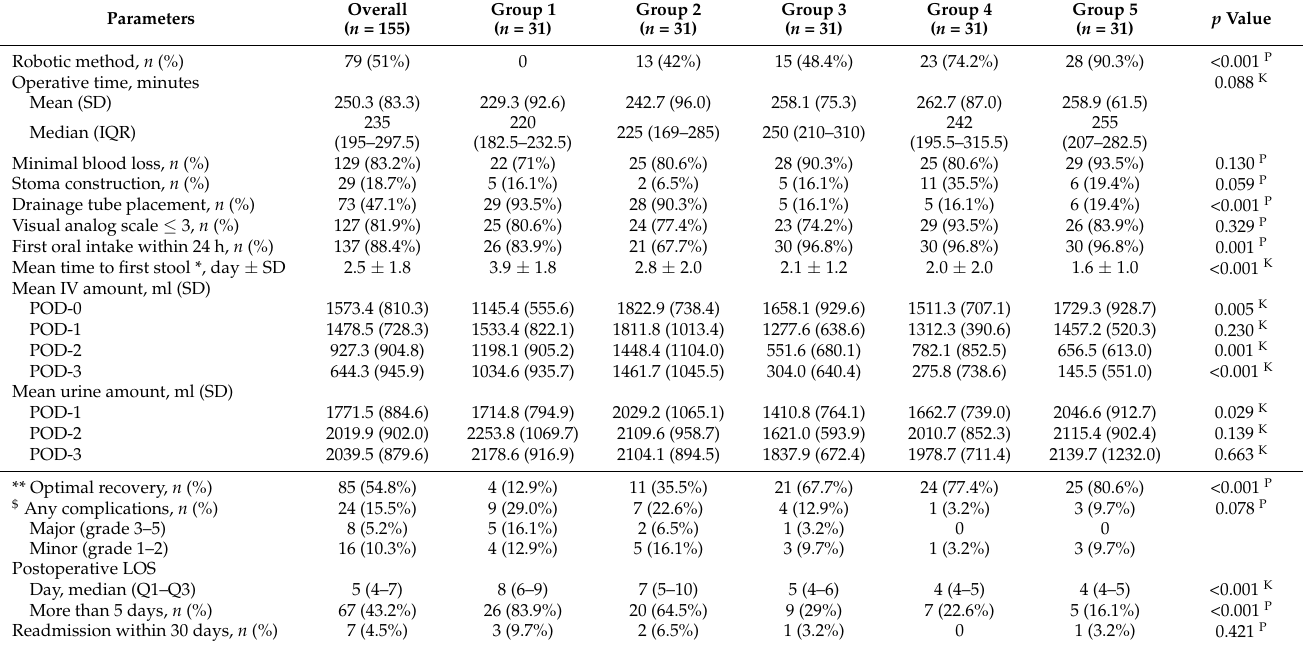
Table 5. Perioperative data and clinical outcomes analysis of patient